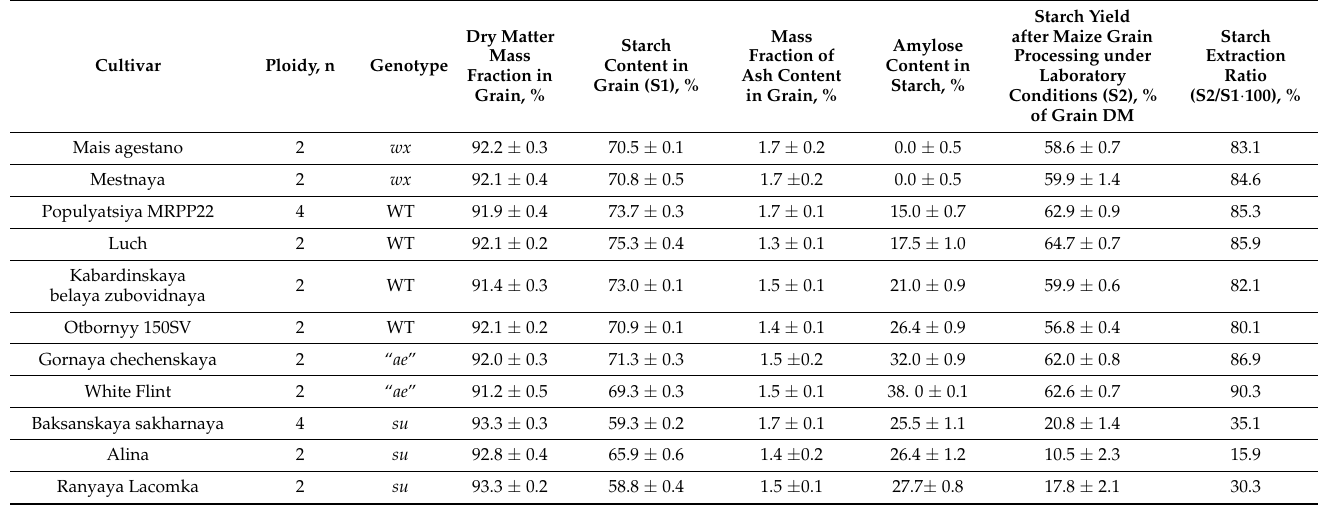
Table 1. Values of the main components in the grain’s endosperm of different maize genotypes and effectiveness indicators of their processing into starch.